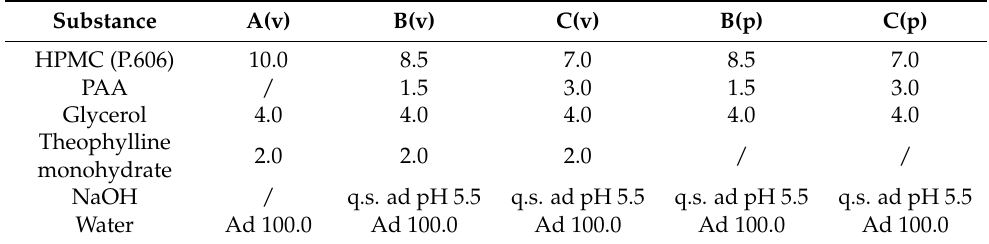
Table 5. Polymer solutions for the development of mucoadhesive tandem films (quantities in mass percent, v: verum, p: placebo). Tandem films were cast from combinations of A(v) + B(p) and A(v) + C(p).